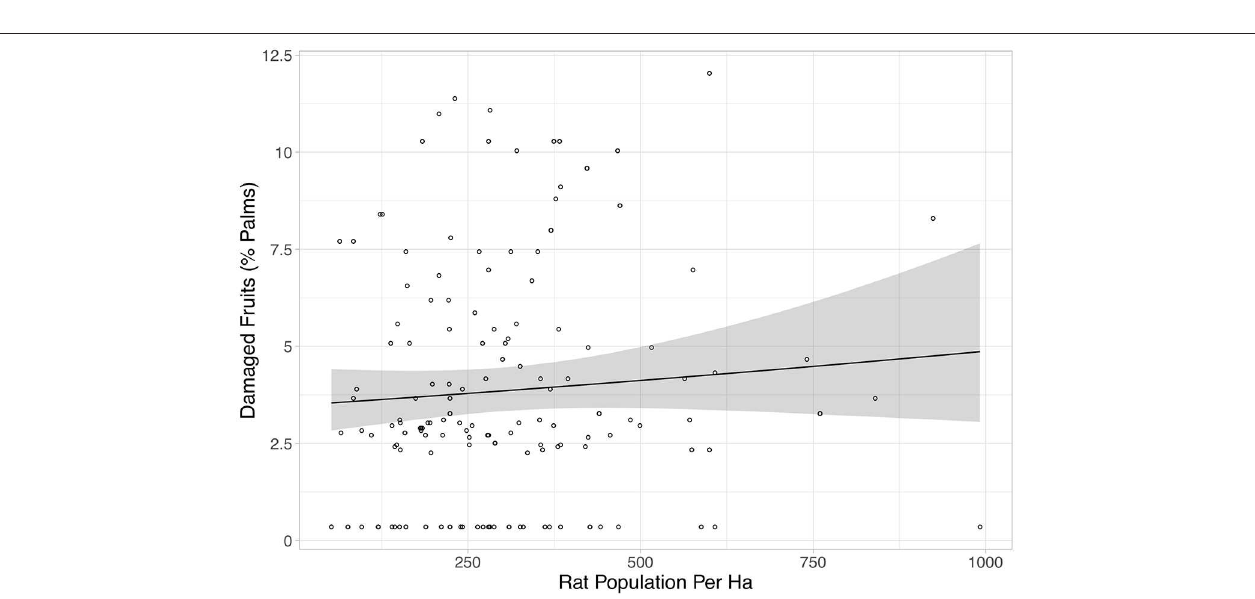
FIGURE 4 | Rat population per ha against Leopard Cat activity (number of observations). Each individual point represents a single plot, and all treatments and time points when the camera traps were active are included. The black line is the line of best fit (Equation 4 in Supplementary Information , Equation 4 in Table 1 ), and shaded area shows 95% confidence intervals.